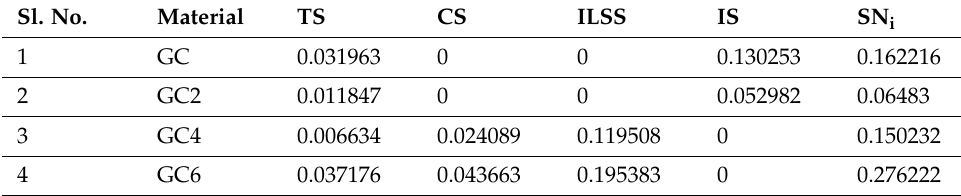
Table 8. Weighted sum of NDA.